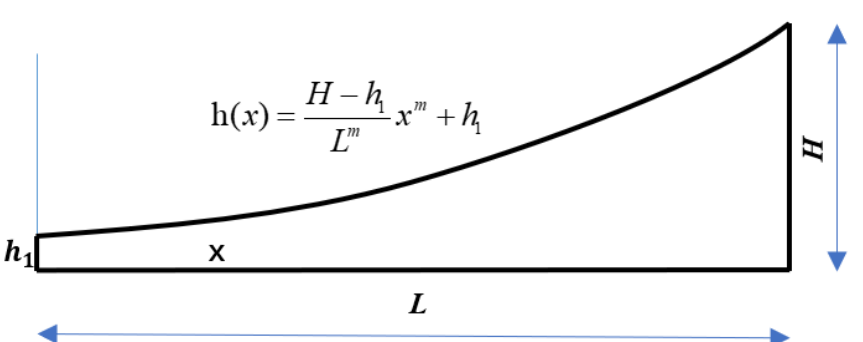
Figure 1. One-dimensional ABH shape outline.